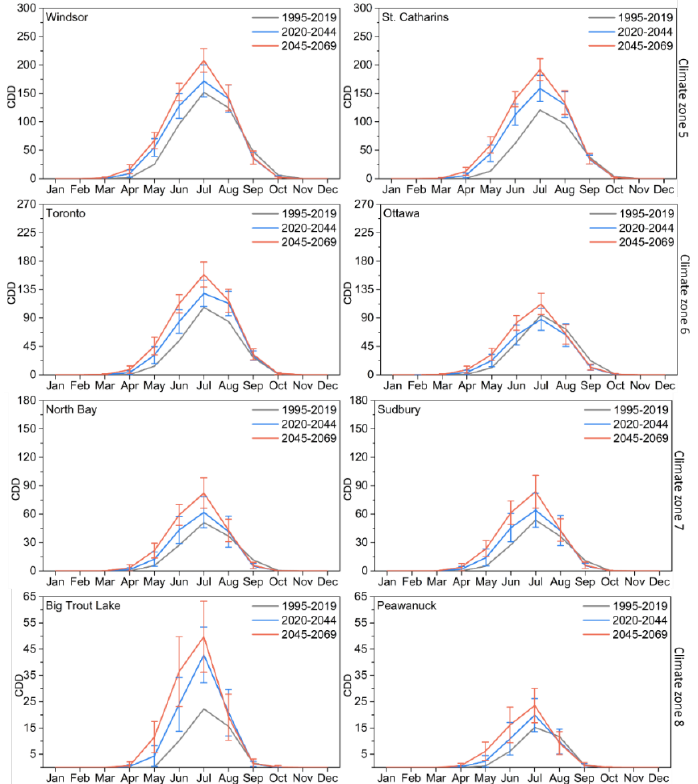
Figure 6. Historical (1995–2019) and future (2020–2069) monthly CDD for selected cities.